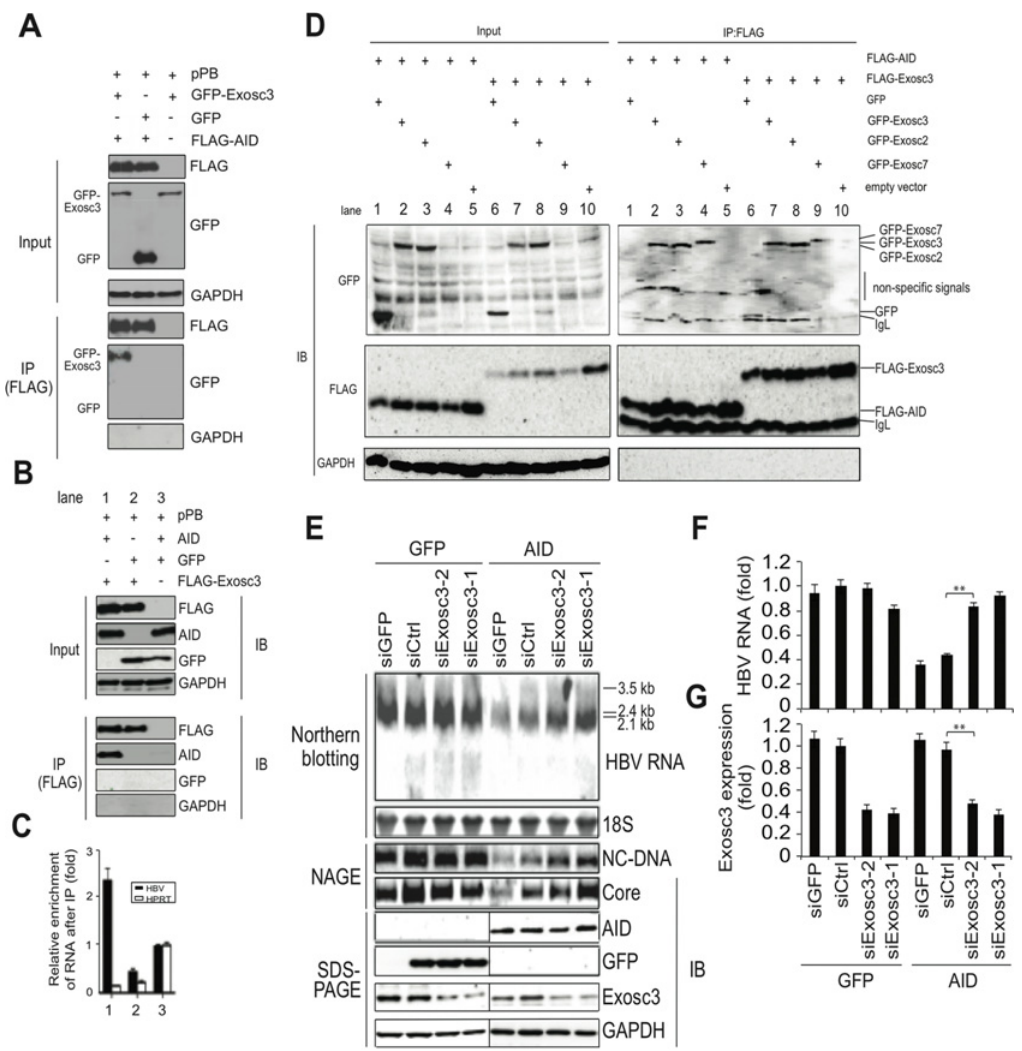
Fig 5. AID inducing HBV RNA reduction depends on Exosc3. (A, B) Huh7 cells were co-transfected with pPB and the indicated protein expression vectors, and were cultured for 3 days. Crude extracts (input) were then subjected to IP using an anti-FLAG antibody, and crude extracts and IP fractions were analyzed using western blotting. (C) Fold enrichment of HBV or HPRT transcripts upon anti-FLAG-Exosc3 IP; To determine RNA coprecipitation with the RNA exosome component Exosc3, Huh7 cells were transfected with pPB, pFLAG-Exosc3, and pCMV-AID (or pEGFP-C2), and were cultivated for 3 days. IP using anti-FLAG antibody was then performed, complexes of FLAG-Exosc3 were then eluted using free FLAG peptides, and the eluted RNA was analyzed using qRT-PCR. Combination of expression vectors used for transfection is the same with B (see numbers below the graph), and values in lane 3 were defined as 1. Error bars represent standard errors of the mean. (D) Associations of AID with RNA exosome proteins; Huh7 cells were co-transfected with indicated expression vectors, and were cultured for 3 days. Crude extracts (input) were subjected to IP with FLAG antibody, and crude extracts and IP fractions were analyzed using western blotting. Expression levels of GFP-Exosc7 were too low to be visualized in the crude extract (lanes 4 and 9, input), but GFP-Exosc7 was clearly detectable after FLAG-AID and FLAG-Exosc3 immunoprecipitation (lanes 4 and 9, IP). (E) Huh7 cells were co-transfected with pPB and either AID or GFP expression vectors and each of the siRNAs indicated in E and F, and cells were cultured for 3 days. HBV transcript levels, nucleocapsid formation, and Exosc3 expression were estimated using northern and western blotting, NAGE assays (E), and qRT-PCR analyses (F and G); siGFP and siCtrl were used as controls; ** P < 0.01 ( t -test); Data are representative of two to three independent experiments and error bars represent standard errors of the